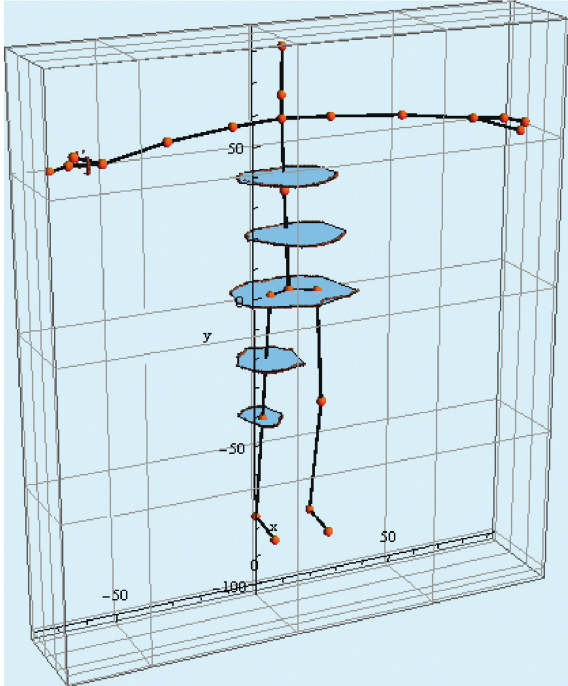
Figure 7: Complex 3D garment measurements: perimeters at chest, waist, hip, thigh, and knee (units in cm).